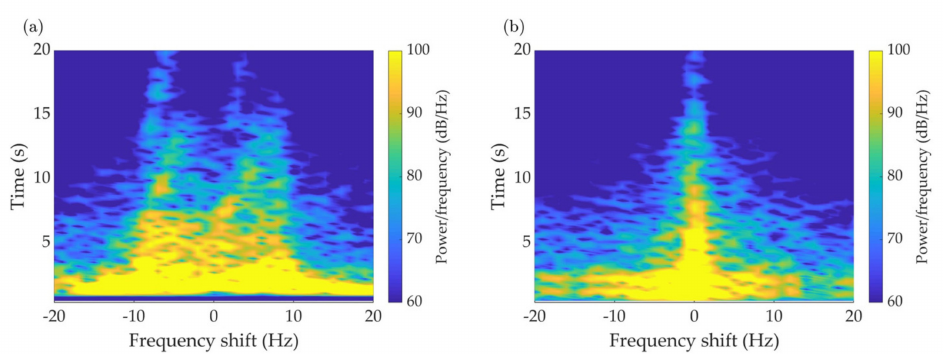
Figure 13. Modeled spectrogram using the data information of Figure 10a. ( a ) Considering the platform motion and ( b ) not considering the platform motion.